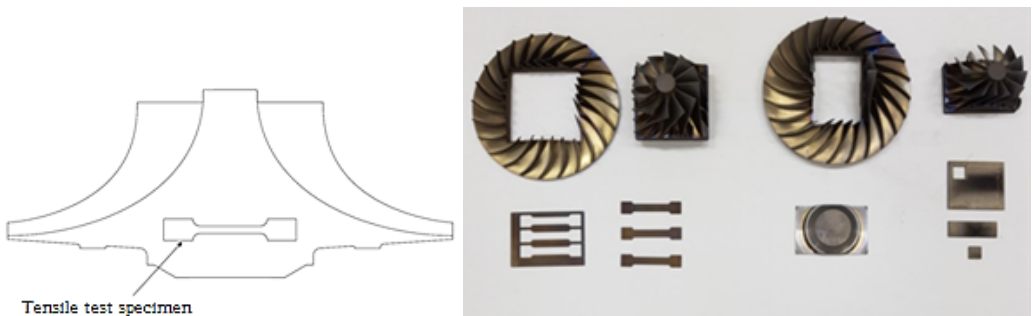
Figure 2. Impeller test specimens.